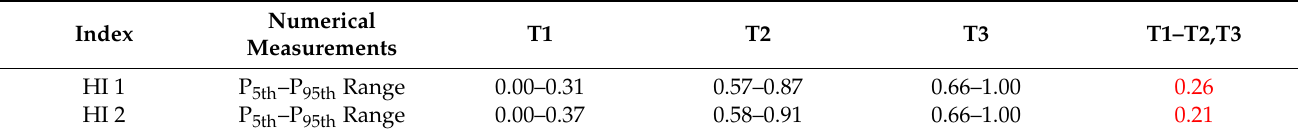
Table A2. Normalized HySpex indices for tree 1–3. The last column shows the normalized distance between infested (T1) and healthy (T2 and T3) spruces. Due to the positive difference (see red numbers), both indices are suitable for differentiating between healthy and infested spruce. Due to the larger difference, HI 1 is less prone to misclassification than HI